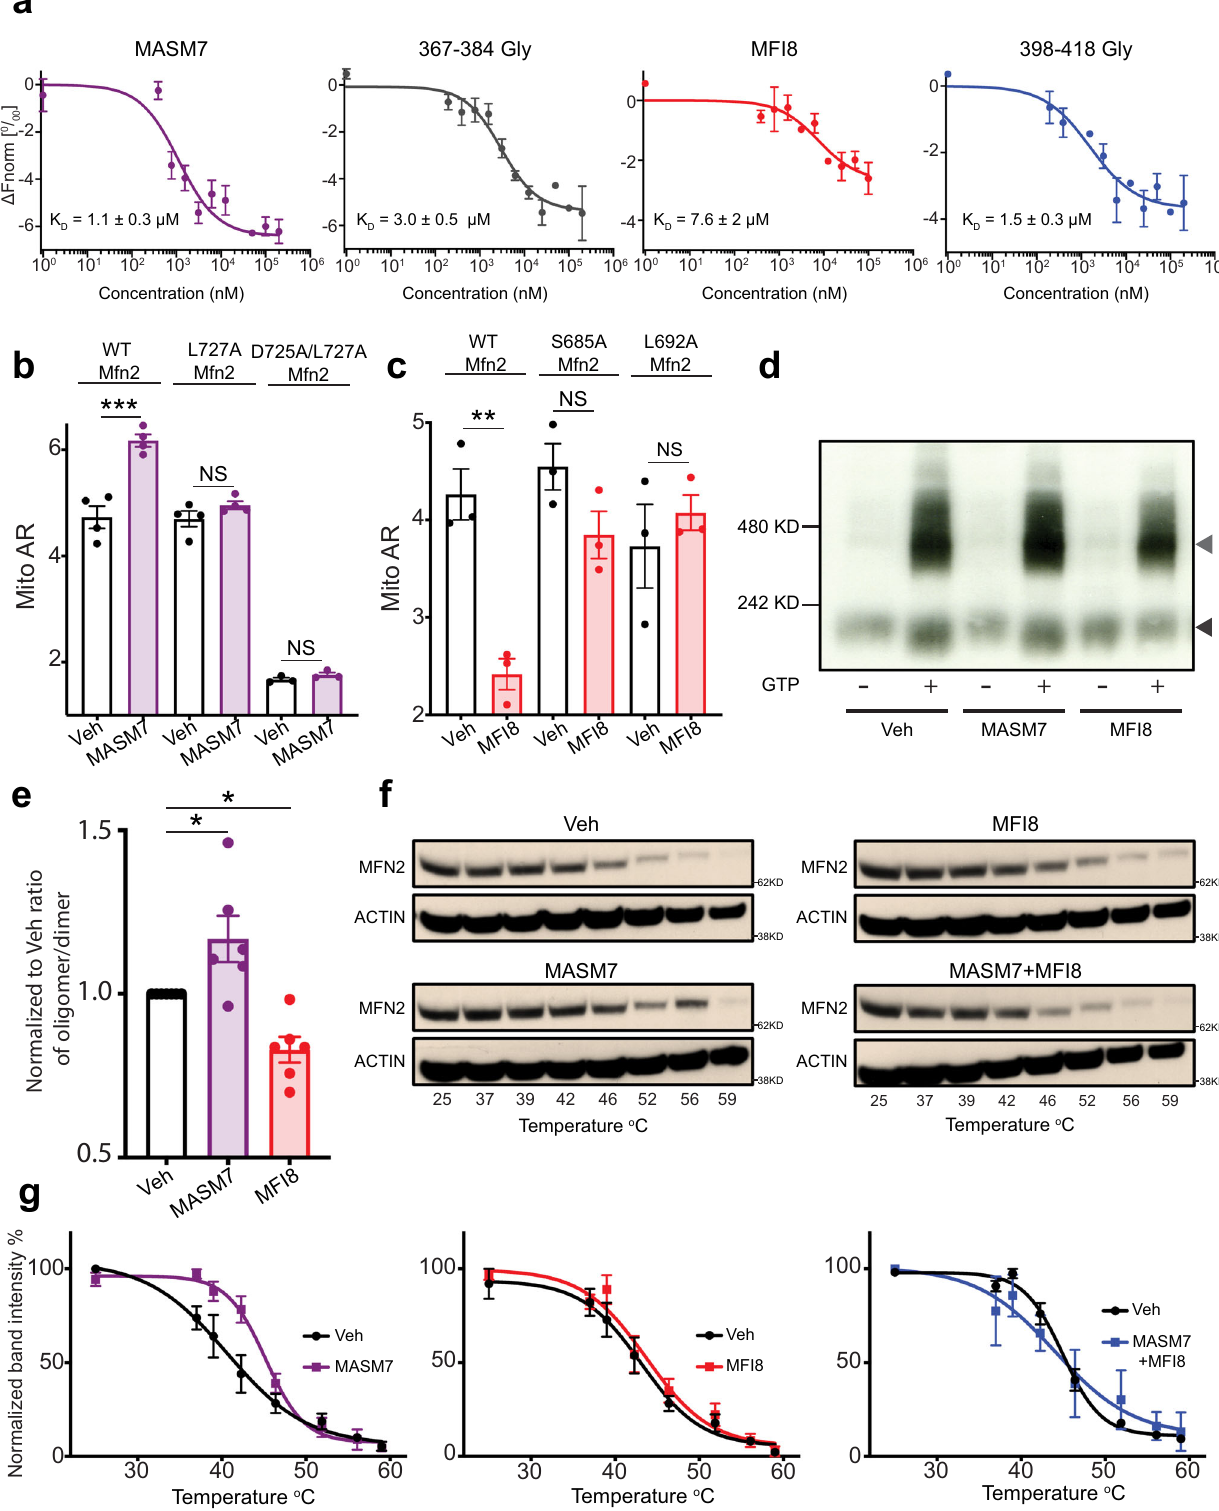
interactions with the HR2 domain during molecular dynamic simulations (Supplementary Figs. 4c – e, 6c – e). Collectively, MST, NMR, molecular modeling and mitochondrial morphology data supported that MASM7 and MFI8 speci fi cally interact with the HR2 domain as predicted from our pharmacophore